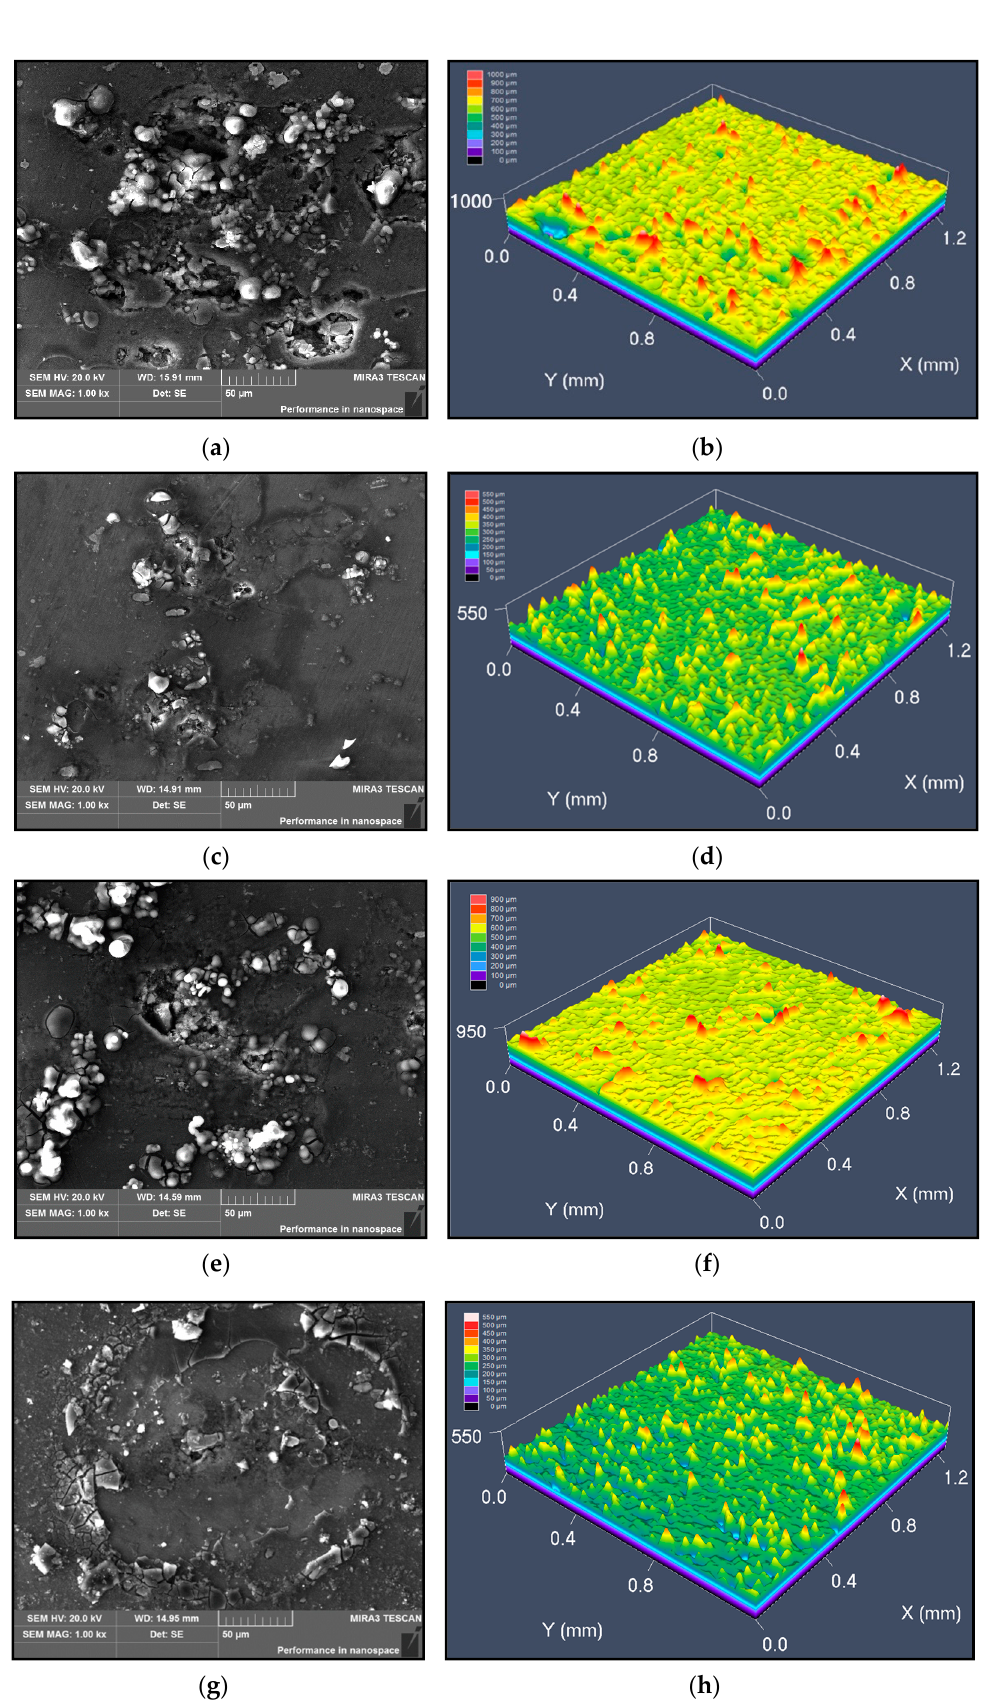
Figure 7. Corrosion morphology and laser confocal maps at: ( a , b ) T = 155 °C, t = 6 h; ( c , d ) T = 155 °C, t = 24 h; ( e , f ) T = 175 °C, t = 6 h; ( g , h ) T = 175 °C, t = 24 h.